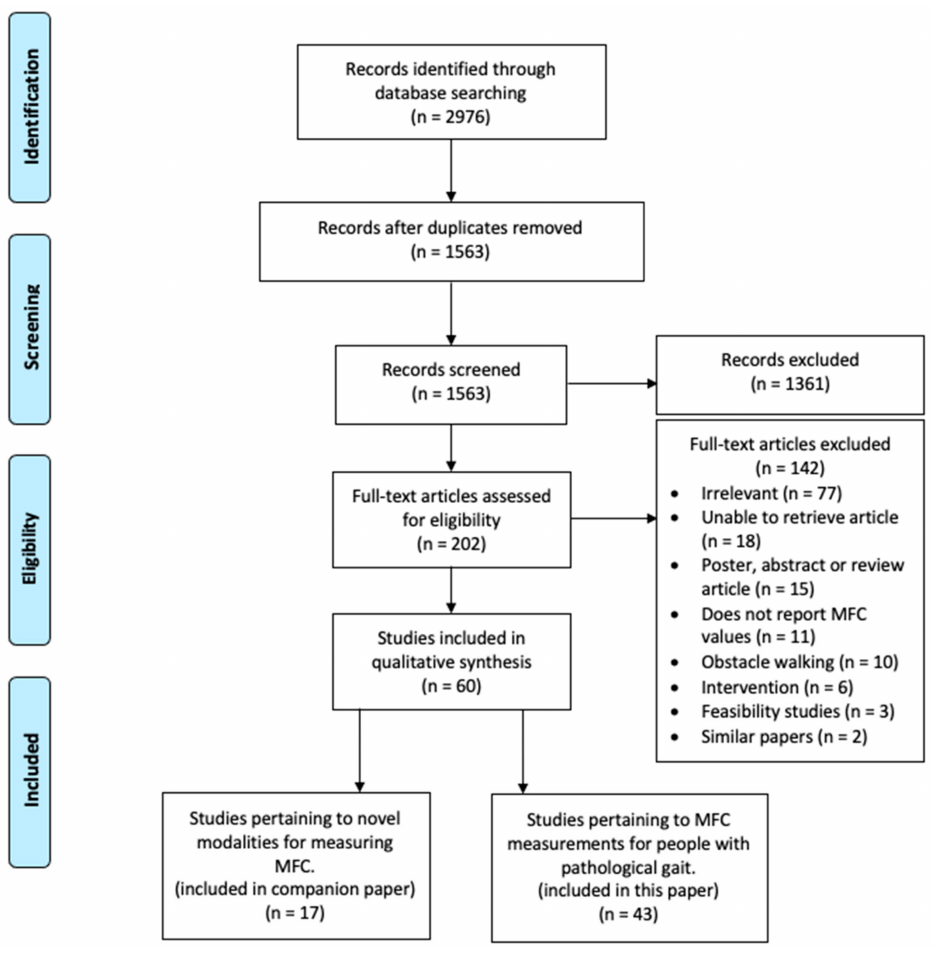
Figure 2. PRISMA flow diagram of study selection